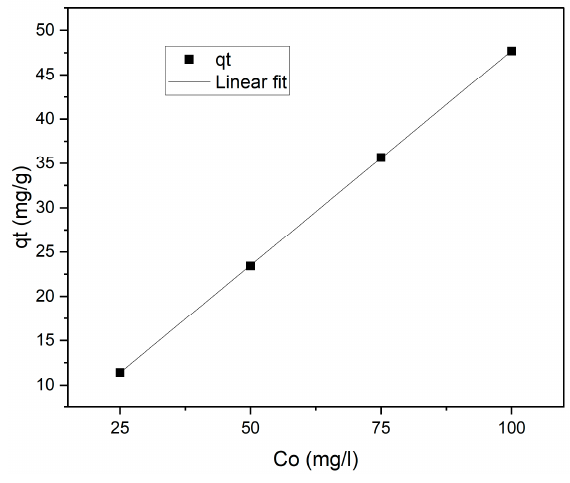
Figure 3. The effect of initial concentration on adsorption. Four phenol solutions were prepared with concentrations ranging from 25, 50, 75, and 100 mg/L. A plot of the percentage of phenol adsorbed versus the initial concentration was made for each sample of nanopowder in each solution concentration. Figure 4 indicates that the percentage of phenol adsorbed increased for each sample as the initial concentration increased. This demonstrates that more light is being absorbed by a solution of greater concentration. This makes sense because when the concentration of a solution goes up, there are more particles for the light to hit, so there are more chances for absorption [23].